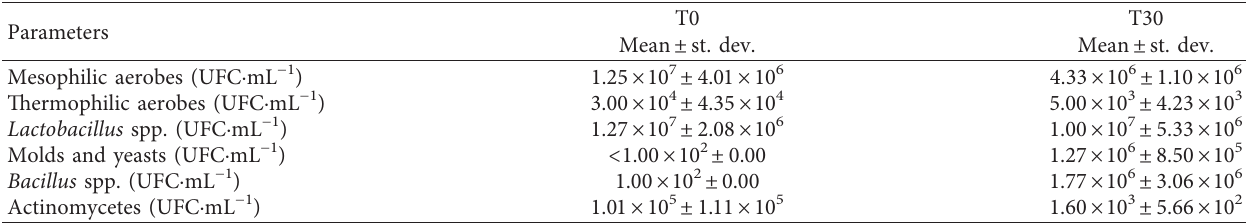
Table 5: Microbiological analysis of pathological microorganisms PM in the activated stock solution ASS ( n � 3). Parameters